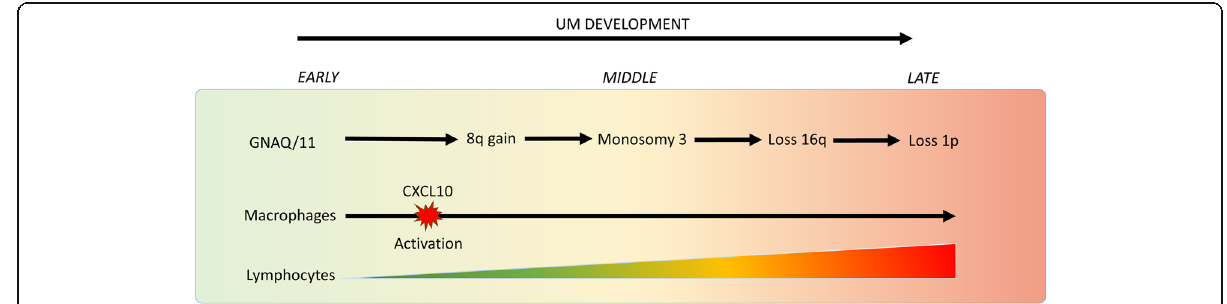
Fig. 6 UM development where multiple processes within a UM occur simultaneously. UM progression coincides with macrophage activation while the consequential chemokine expression (CXCL10) of activated macrophages is correlated with an influx of